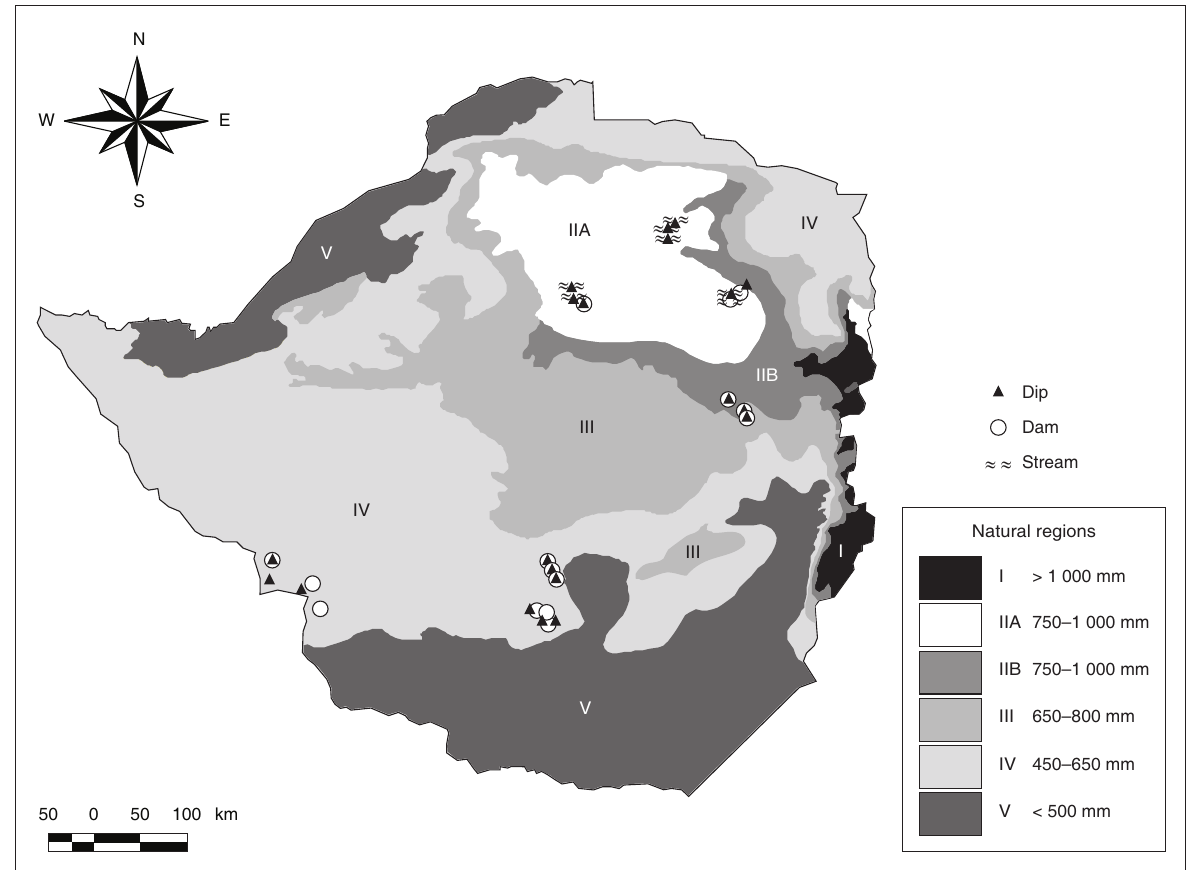
FIG. 1 Location of dipping tanks and snail habitats sampled in the different natural regions in the highveld and lowveld communal grazing areas of